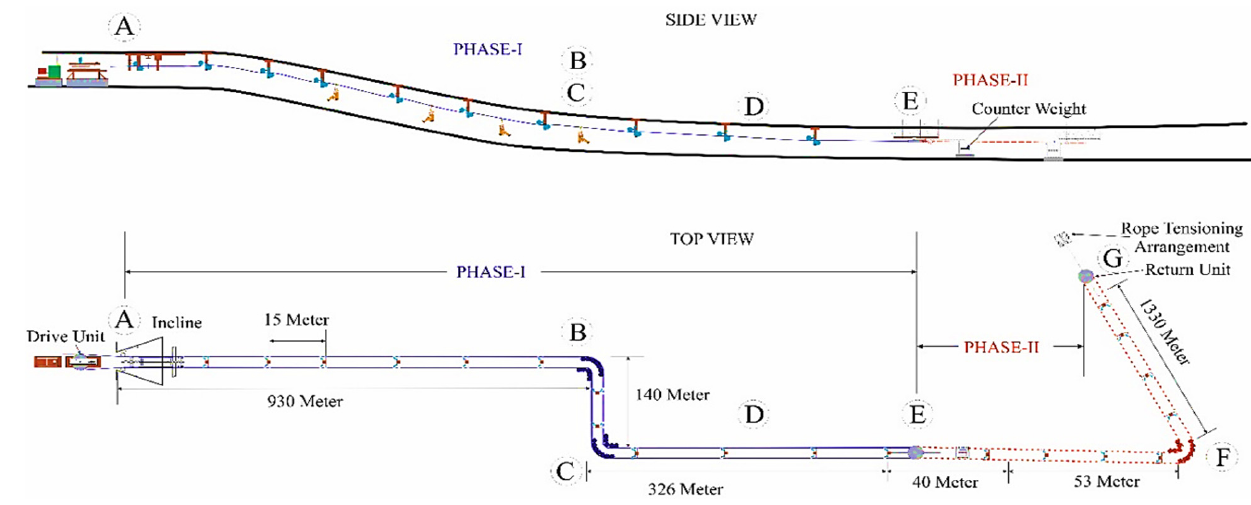
Figure 9. Top View and Side View of MRCL.